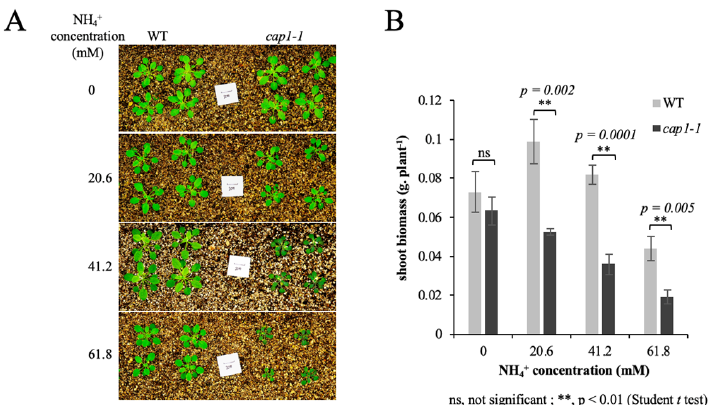
Figure 1. Shoot phenotypes of wild-type (WT) and cap1-1 plants growing on media with different concentrations of NH 4+ . ( A ) Growth of the WT and the cap1-1 mutant in response to different growth condition. Scale bars = 1 cm. ( B ) Shoot fresh weights of WT and cap1-1 plants in ( A ) were averaged. Seven-day-old seedlings were transplanted to a pot containing only vermiculite. Solutions containing 0, 20.6 mM, 41.2 mM, or 61.8 mM NHCl 4 were applied to the respective plants for about 4 weeks, and then pictures were taken. Values are the means ± SE, n = 8–11. (Independent samples t -test; ns, not significant; **, p < 0.01.)